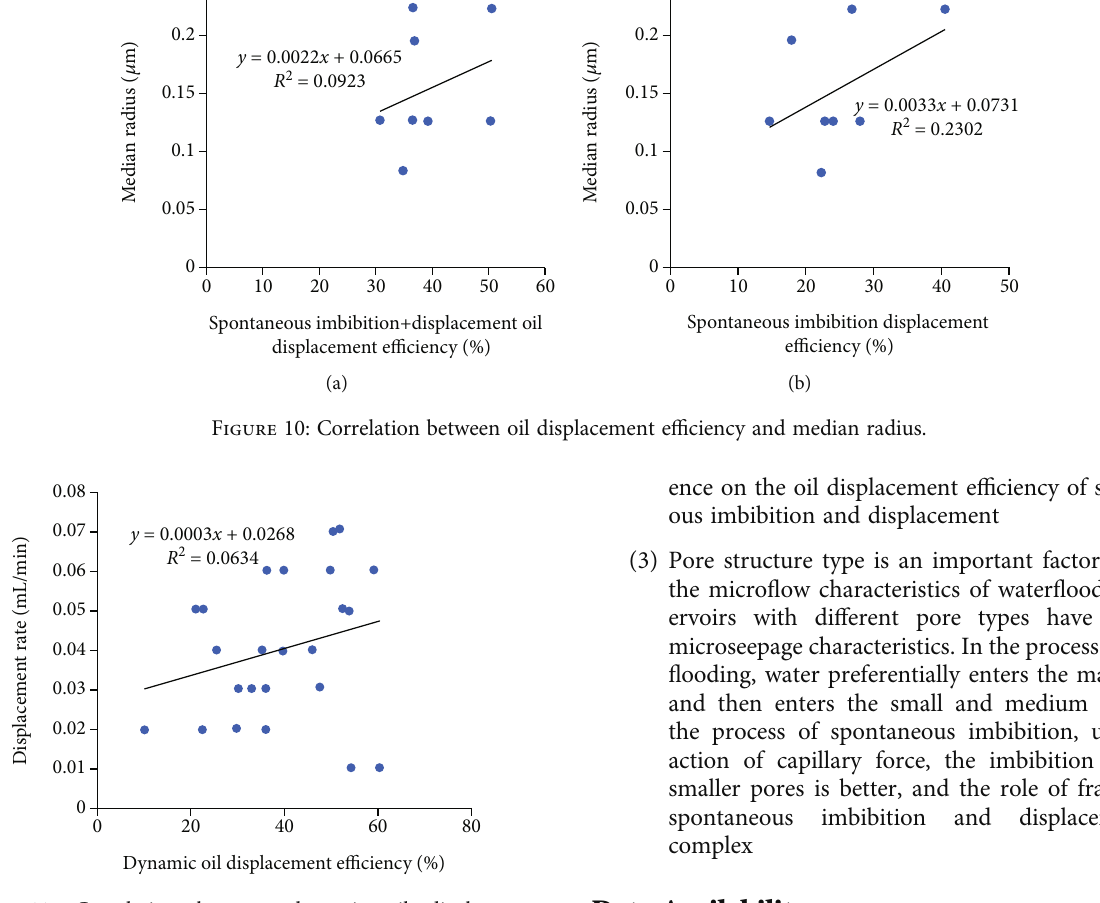
Figure 11: Correlation between dynamic oil displacement e ffi ciency and displacement